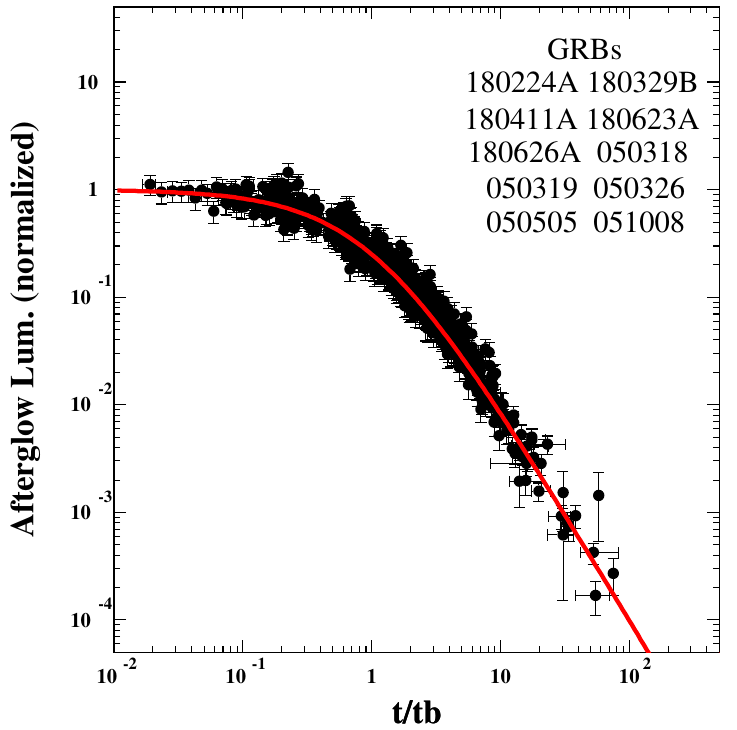
Figure 20. Comparison between the normalized light curve of the X-ray afterglow measured with Swift XRT [95,96] of 12 SN-less GRBs with a well sampled AG in the first couple of days after burst and their predicted universal behavior, Equation